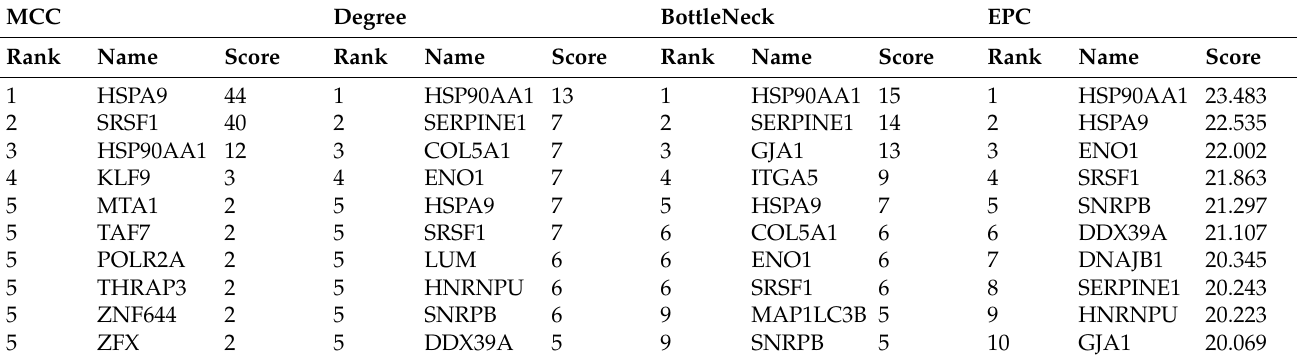
Table 1. Top 10 proteins encoded by the hub genes in the PPI network ranked using four methods.